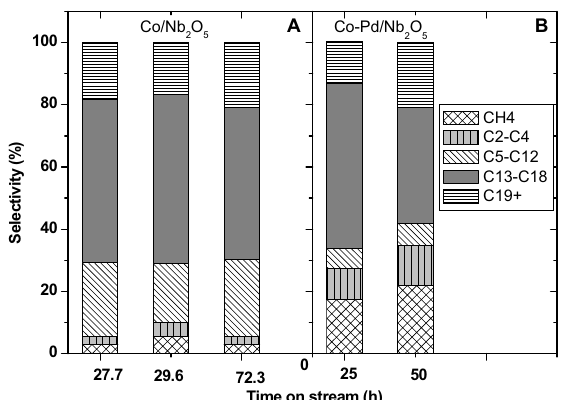
Fig. 3 – Influence of reduction temperature on selectivities for Co/ Nb 2 O 5 . ◦ : S C 1 ; (cid:3) : S CO 2 ; 5 : S C 2 S C + + O ; H 2 :CO = 2, P = 1 atm, T reaction = 533 K (Rosenir et al. 5 1993).